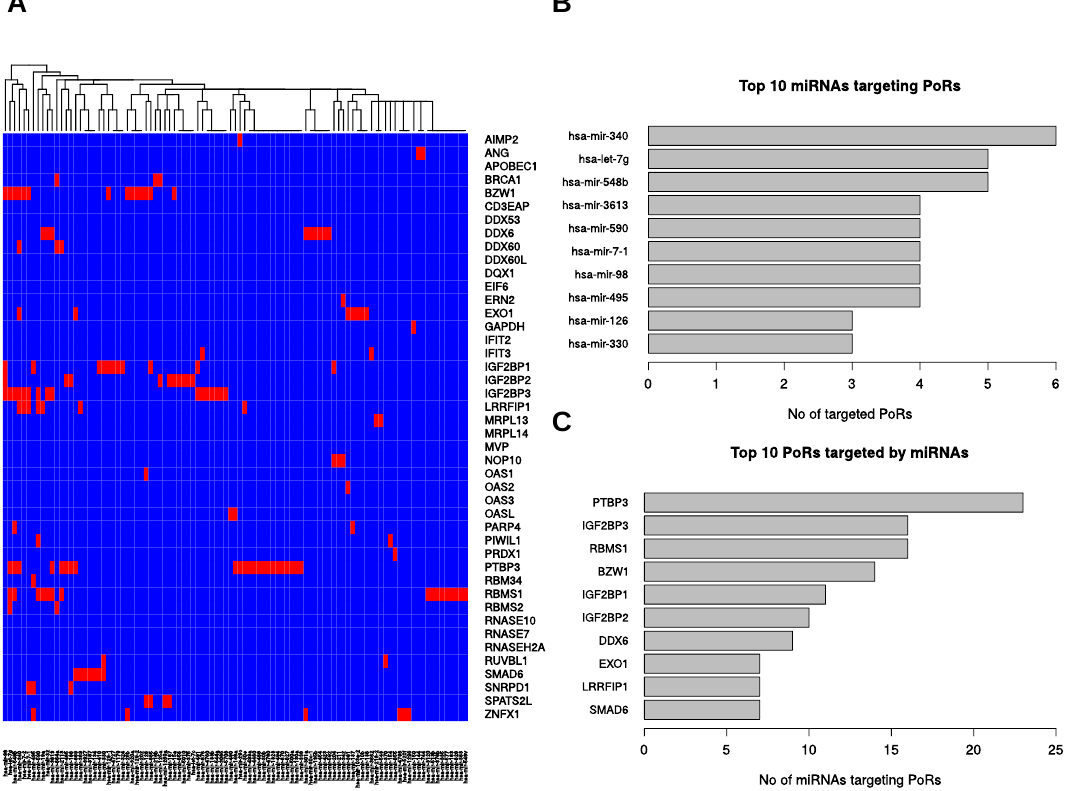
Figure 5. Putative interactions between PoRs and microRNAs. ( A ) Predicted PoR–miRNA-interactions that were associated with significant ( p < 0.05) negative expression correlation (Spearman). Red color encodes inferred interaction, blue means no interaction. ( B ) Top 10 miRNAs targeting the most PoRs. ( C ) Top 10 PoRs targeted by the most